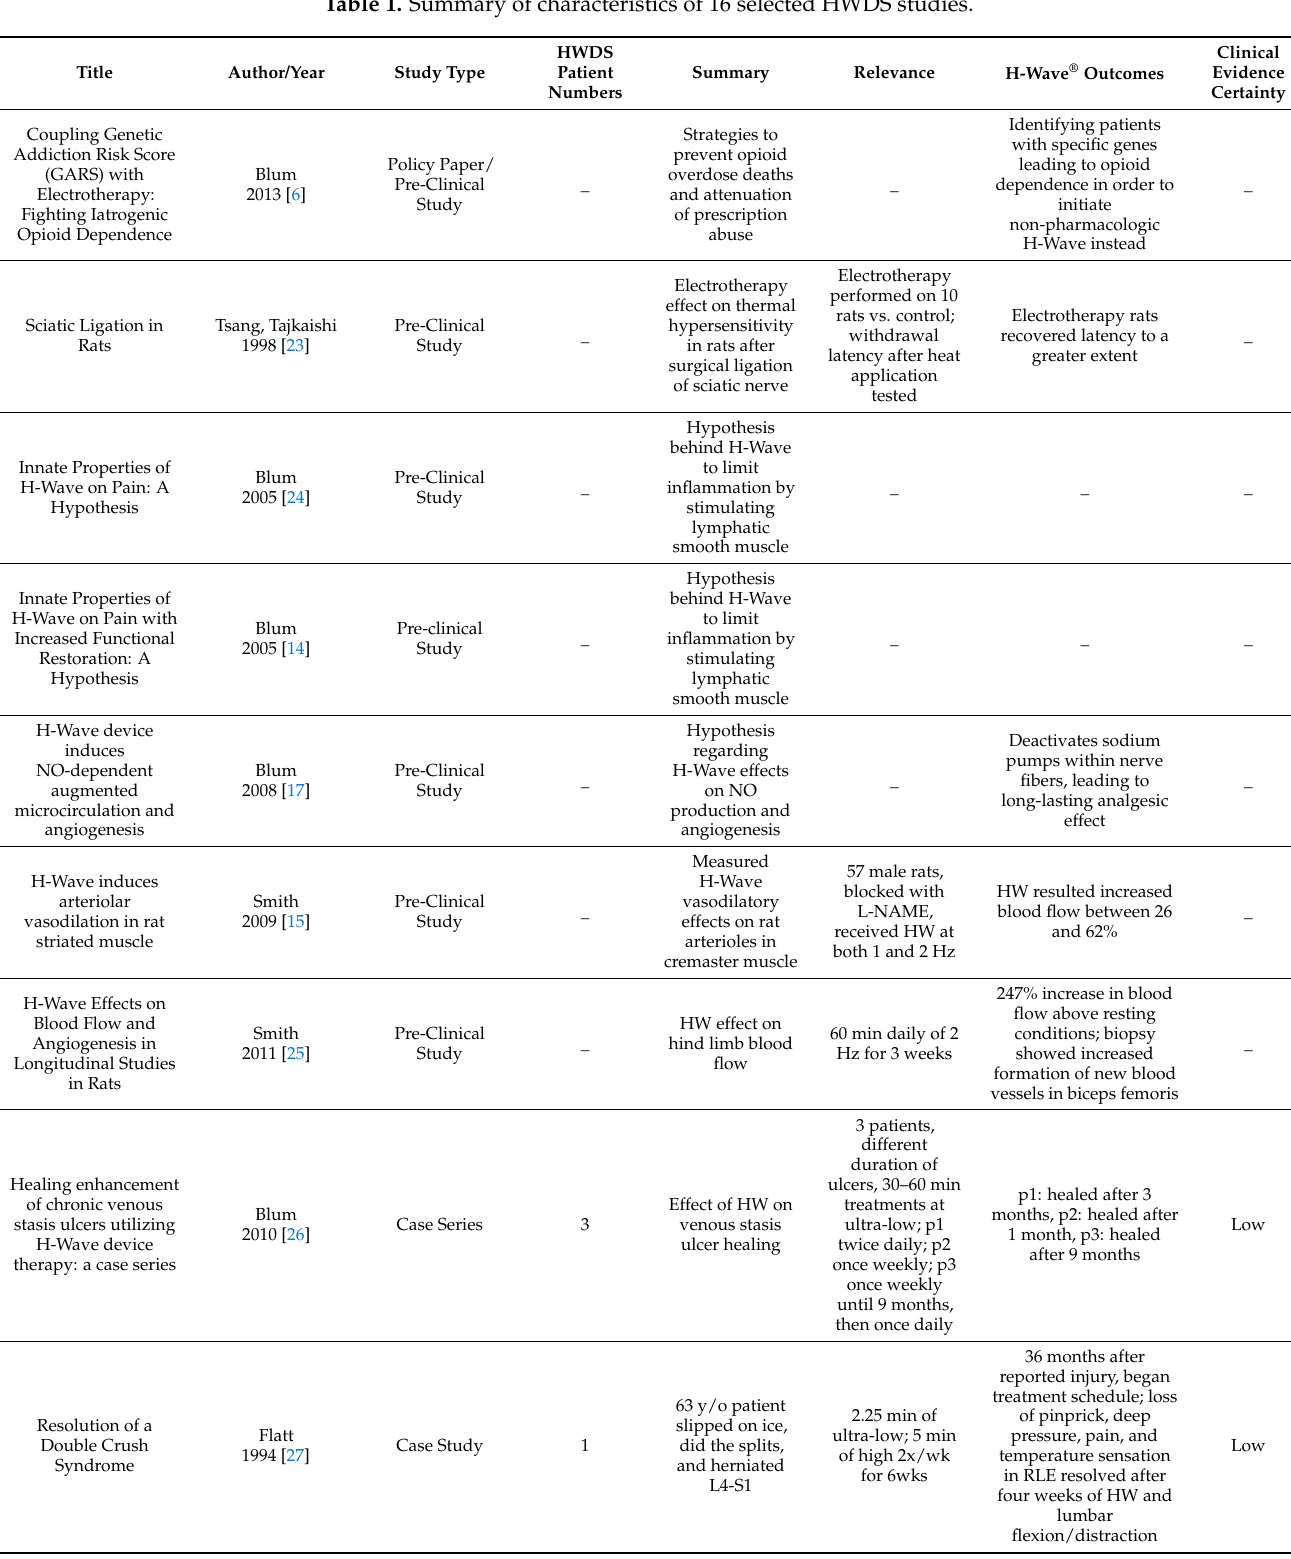
Table 1. Summary of characteristics of 16 selected HWDS